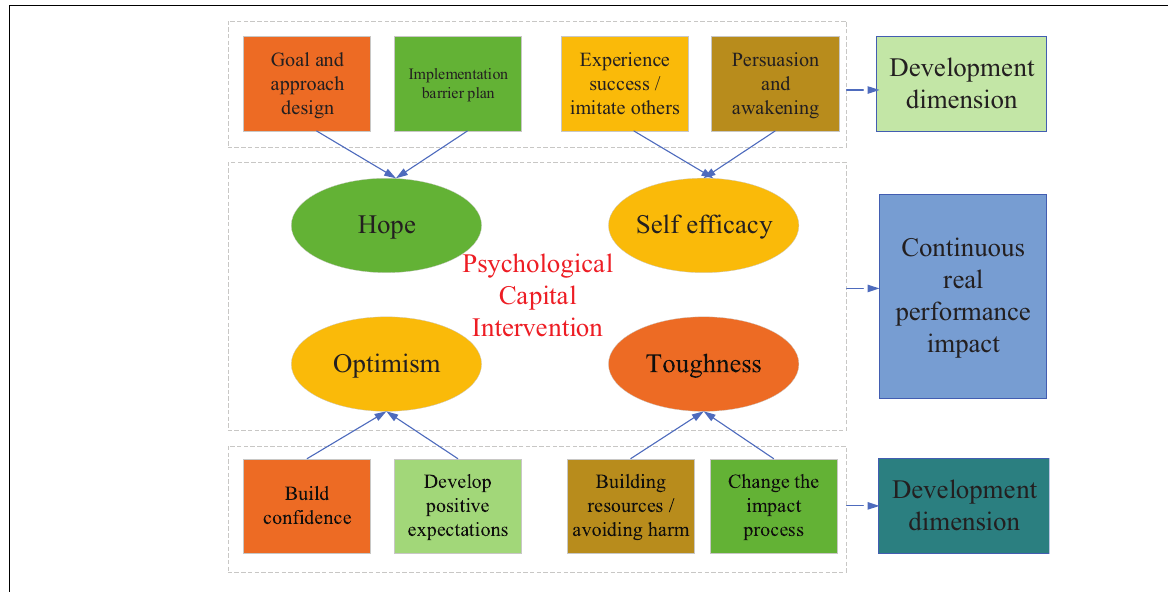
FIGURE 4 | PCI model.